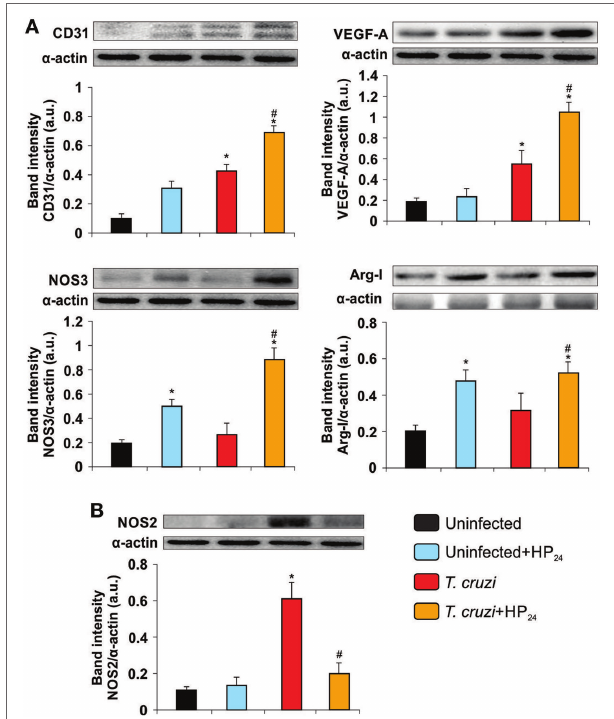
FigUre 8 | HP 24 increases the expression of proangiogenic markers and decreases nitric oxide synthase 2 (NOS2) in the heart of mice infected with Trypanosoma cruzi . Expression of CD31, vascular endothelial growth factor A (VEGF-A), NOS3, Arginase I (Arg-I) (a) , and NOS2 (B) was determined in the heart by Western blot. Anti-CD31, anti-VEGF-A, anti-NOS3, anti-Arg-I, and anti-NOS2 specific antibodies were used, and protein levels were normalized against α -actin. Results show a representative experiment out of three performed. Results represent the mean band intensity ± SEM of three independent experiments (five mice per group). * P < 0.05 vs. uninfected mice, # P < 0.05 vs. T. cruzi -infected